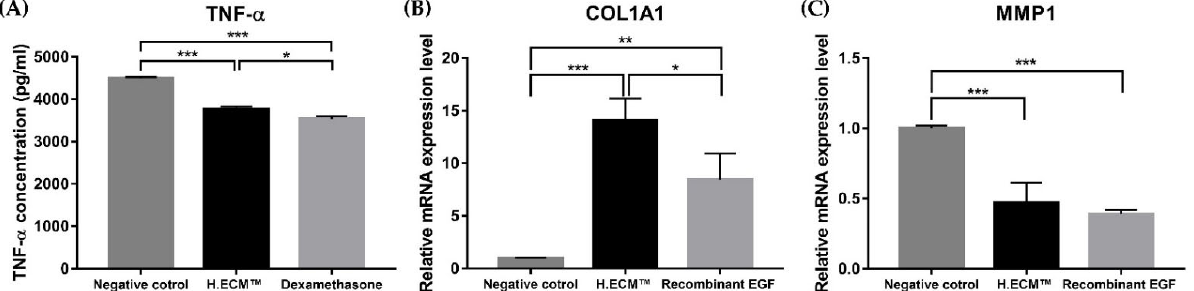
Figure 4. Variations in the expression levels of tumor necrosis factor ( TNF) – α expression between the negative control, 1 µ M Dexamethasone treatment and 0.05% H.ECM TM liposome groups compared to the LPS-treated RAW 264.7 cells ( A ) Expression levels of COL1A1 and MMP1 genes. The expression levels of COL1A1 ( B ) and MMP1 ( C ), representing the expression of wrinkle-related factors, improved with 0.05% H.ECM TM liposome treatment compared to the negative control group of HDF cells ( B ). The 10 ng/mL recombinant EFG treatment was used as a positive control. * p < 0.05, ** p < 0.01, *** p < 0.005.